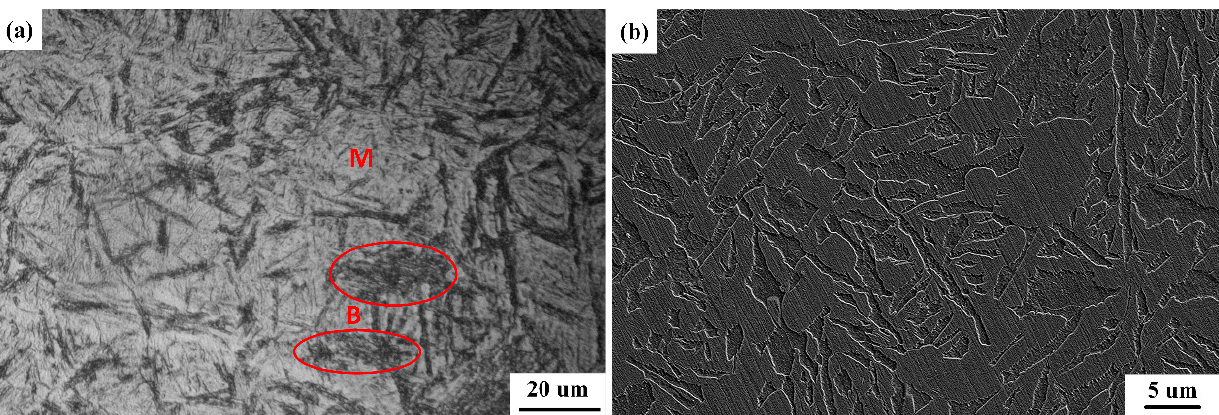
Figure 2. OM ( a ) and SEM ( b ) images of 35CrMo steel after oil quenching.